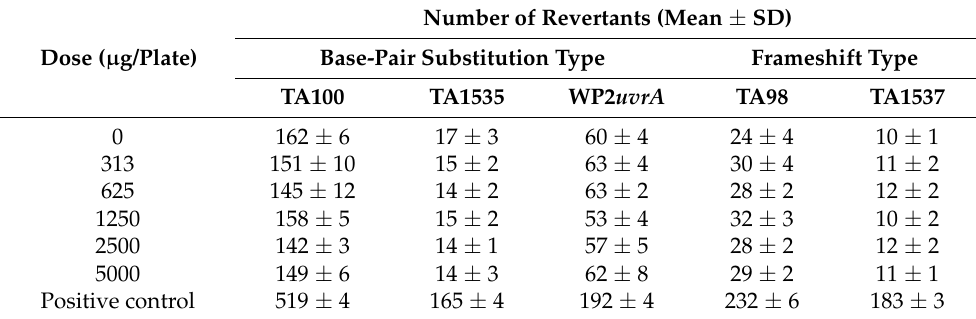
Table 3. Mutagenicity testing of FDAE in the Salmonella typhimurium /microsome assay with S9 metabolic activation on TA100, TA1535, TA98, TA1537 and WP2 uvrA tester